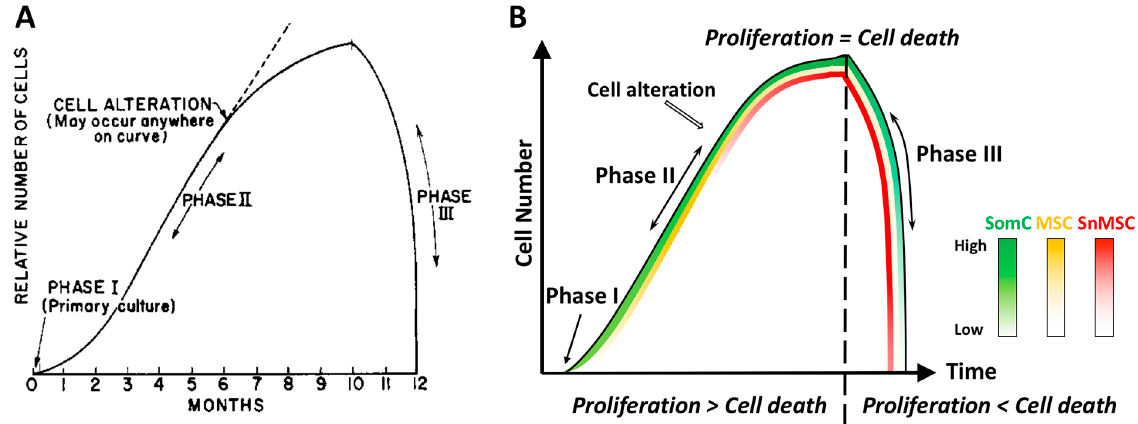
Figure 1. Diagram representations of the Hayflick phenomenon. ( A ) Classic Hayflick model [5]. Phase I is the primary culture. Phase II is defined as the multiple cell passage period characterized by robust cell proliferation and increase of cell number. After subcultures of 40–60 passages, cells reach Phase III with halting proliferation followed by rapid cell death. Such an event is termed Hayflick Limit, or replicative senescence. ( B ) The SACTAI model. Phase I contains SomCs. During Phase II, cell passaging-induced cell proliferation triggers cell alteration. Some SomCs are converted into MSC and SnMSC due to replicative senescence. Cell proliferation is more than cell death in Phase II. The emergence of SnMSC results in its communication with SomC via SASP, which triggers catabolism and death of SomC. At the end of Phase II, cell proliferation equals death resulting in a cell number plateau. During Phase III, SASP triggered SomC death results in a rapid decline of total cell number. The loss of SomCs depletes the cell pool for proliferation. As a result, SnMSC triggered SomC cell death outpaces its proliferation, resulting in tissue degeneration. Thus, different cell types (SomC, MSC, and SnMSC) contribute to the cell transition and interaction during various phases. They account for aging-associated cellular changes. SomC: somatic cell; MSC: mesenchymal stromal cell; SnMSC: senescent mesenchymal stromal cell.